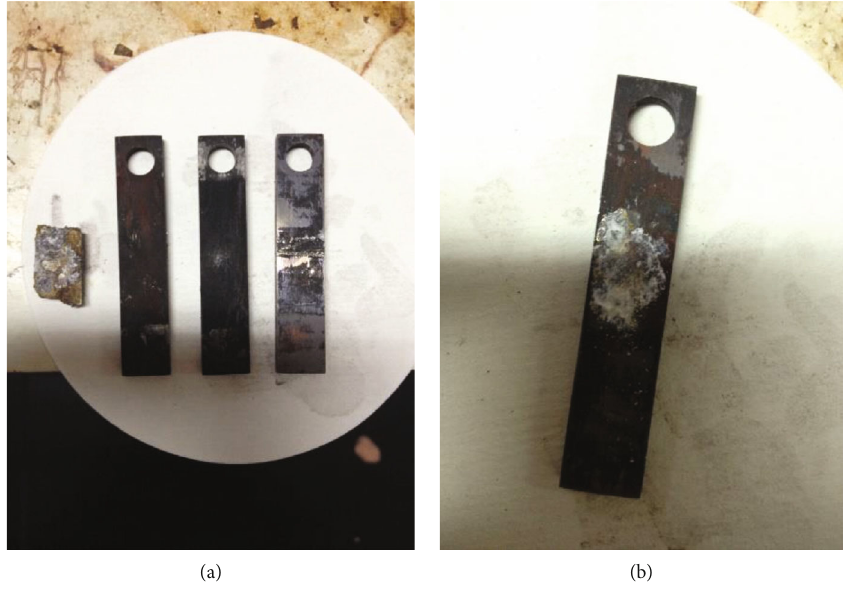
Figure 5: Pictures of experimental coupons.